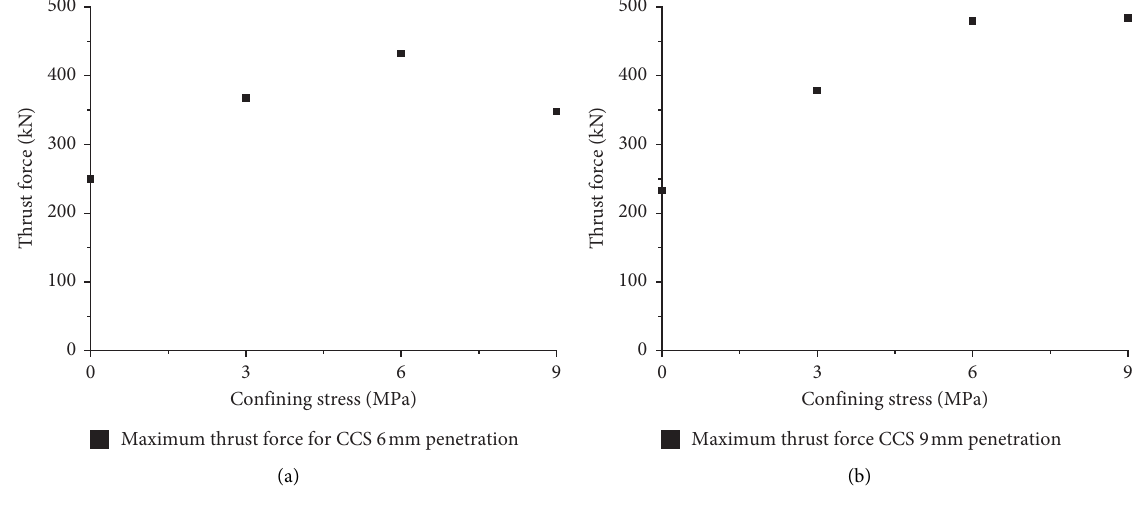
Figure 9: Confining stresses’ influence on maximum thrust force for the CCS disc cutter. (a) Ultimate penetration � 6mm; (b) ultimate penetration � 9